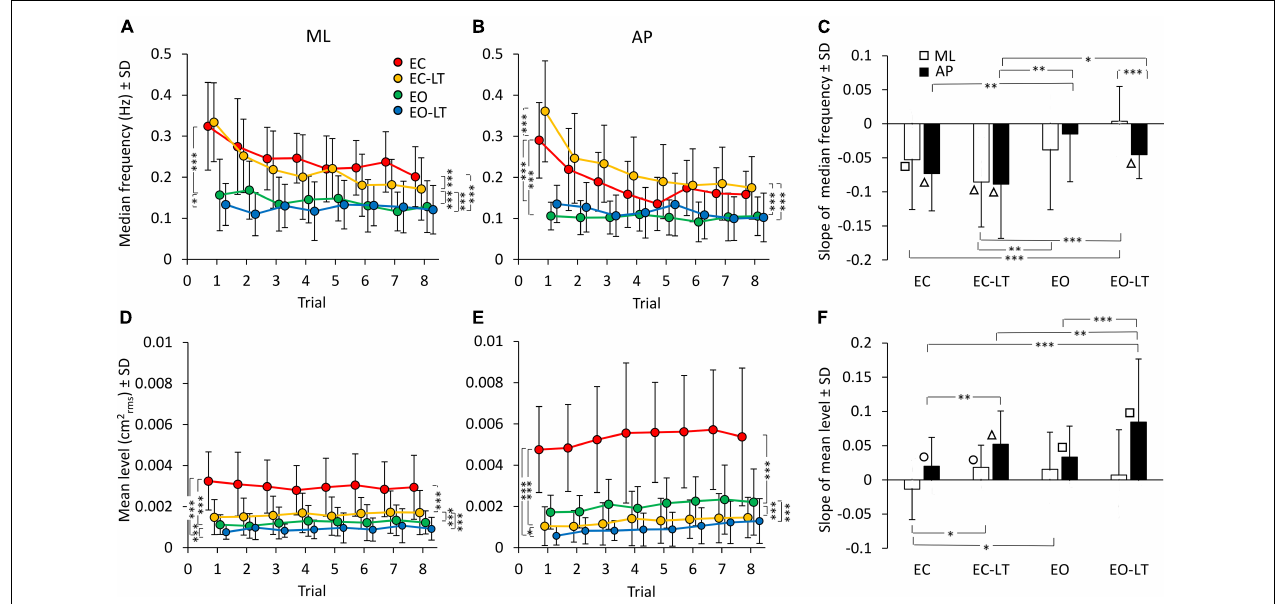
FIGURE 4 | Effect of trial repetition on the median frequency and mean level of the spectrum under the different sensory conditions. Median frequency decreased with trial repetition in the no-vision conditions for both ML (A) and AP (B) directions. Median frequency was higher in EC (red) and EC-LT (yellow) than in EO (green) and EO-LT (blue) conditions. (C) Shows the mean slope of the lines fitted to the median frequency data. Except for EO-LT in the ML direction, all the slopes were negative, indicating a reduction in the value of the median frequency. The mean level of the spectrum for the ML (D) and AP (E) direction is also reported. For the ML direction, the mean level of the spectrum showed no clear changes with trial repetition, while in the AP direction the mean level of the spectrum increased with trial repetition. (F) Shows the mean slope of the lines fitted to the mean levels of the spectrum. Except for the EC in ML direction, all the slopes were positive, indicating an increase of the mean level of the spectrum with the trial repetition. Asterisks indicate significant differences between sensory conditions (* p < 0.05; ** p < 0.01; *** p < 0.001). Symbols indicate slopes significantly different from zero ( p < 0.05; (cid:3) p < 0.01; (cid:77) p < (cid:35)